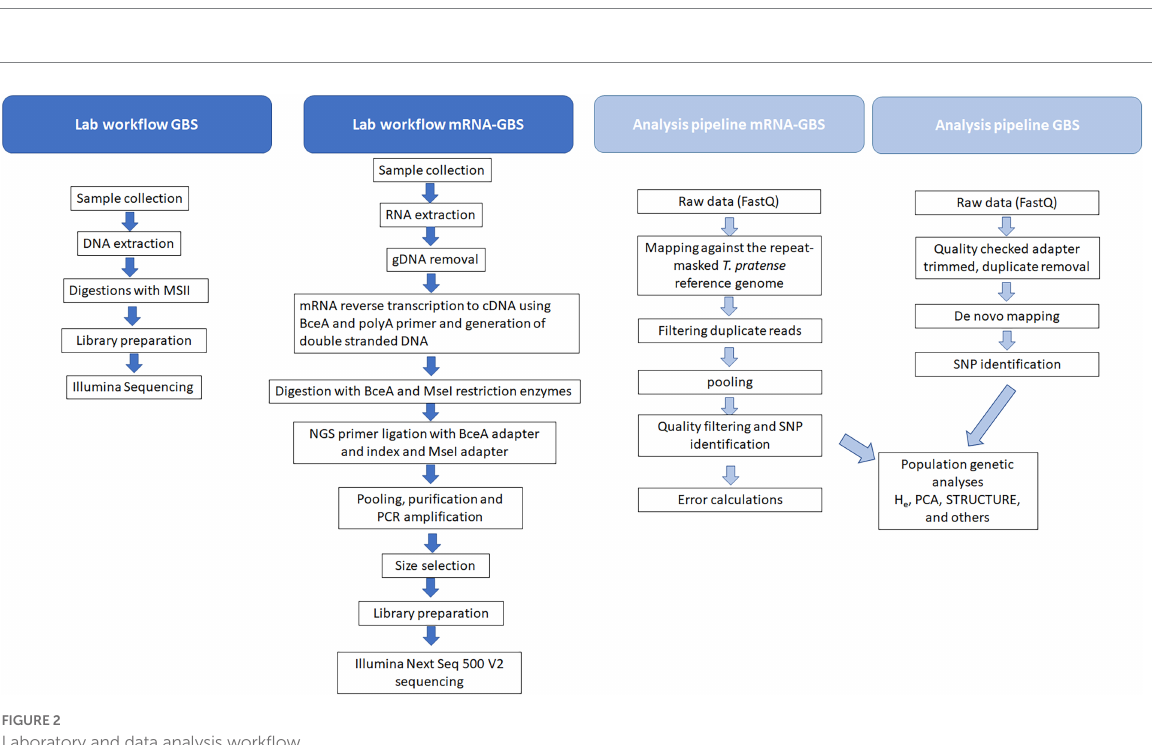
FIGURE 1 Study sites in Germany of the three Biodiversity Exploratory sites (S, Schorfheide-Chorin; H, Hainich-Dün; A, Swabian Alb) with 6 sampled populations per site (three mown (transparent colors) and three unmown (rich colors)) for the mRNA-GBS analysis and the GBS analysis and results were compared to the RNA-Seq-study of Herbert et al. (2021) where samples derived from the Hainich-Dün site directly and were cultivated in a greenhouse experiment.